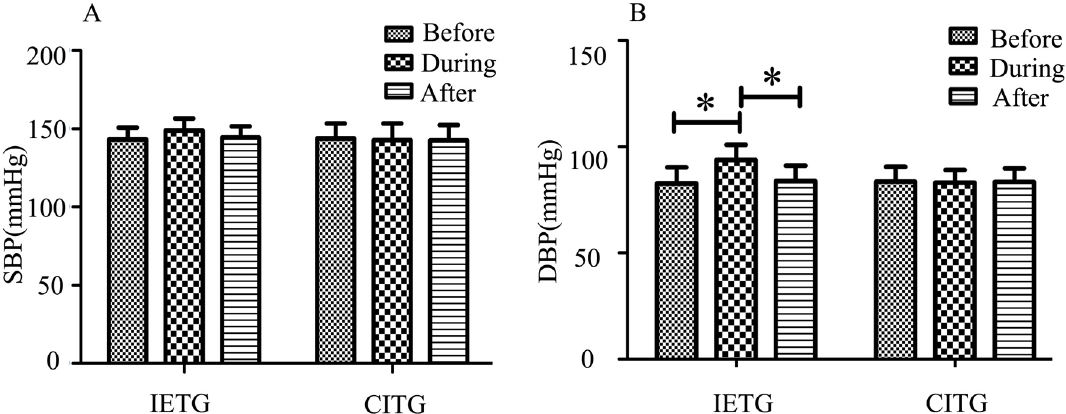
Figure 7 ：Comparison of BP changes during